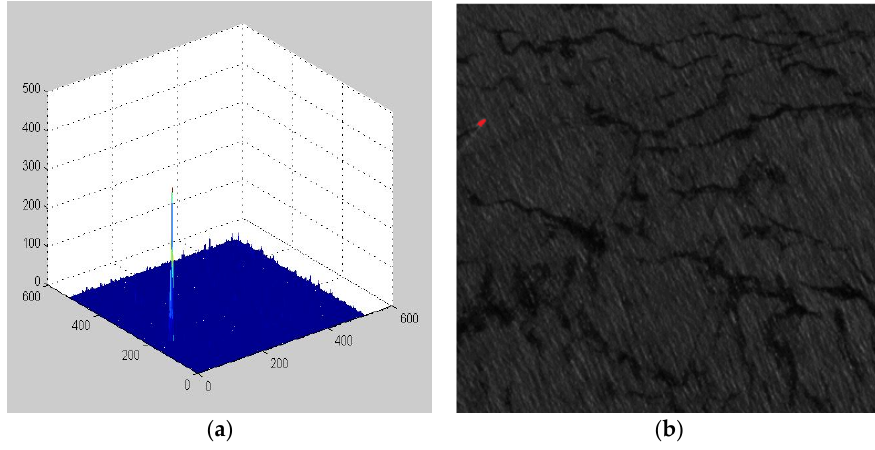
Figure 10. The localization results of strong waves by PSMEWT. ( a ) The three-dimensional display of PSMEWT; ( b ) the localization results of PSMEWT.